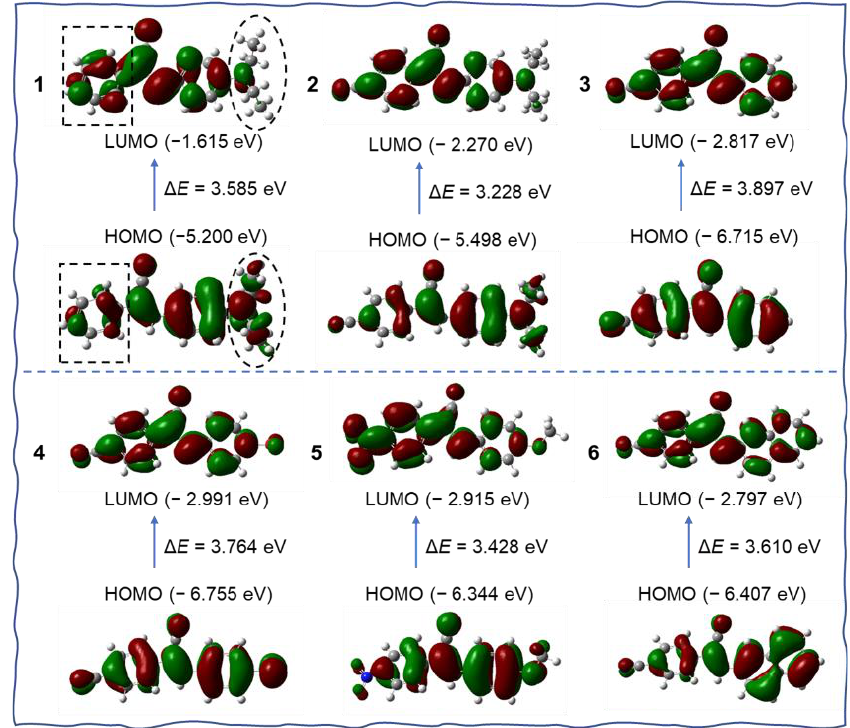
Figure 4. The molecular orbitals of molecules 1 – 6 are calculated by the DFT method. In order to obtain insight into the underlying origins of the remarkable blue-shift and turn-on MC luminescence, the intermolecular interactions in the single-crystal state were studied (Figure 5). Two single crystals suitable for X-ray diffraction were obtained by slow evaporation of the solution of 1 and 2 in mixed CHCl 3 /CH 3 OH solvents. As illustrated in Figure 5A, 1 adopted a twisted molecular conformation in the crystalline state. The dihedral angle between the left phenyl ring and the plane of the double bond is 45.45 ◦ . Such a distorted molecular structure can self-assemble into a loose packing (Figure 5C), which might readily slide upon mechanical grinding to result in MC luminescence. Moreover, some C-H ··· π ( d CH ··· π = 2.896 Å) interactions were obtained in the neighboring molecules (Figure 5B). While the crystal structure of 2 showed a planar molecular conformation and the adjacent molecules arranged in a head-to-tail manner (Figure 5D). Some short contacts, such as C-H ··· π ( d CH ··· π = 3.571 Å), C ≡ N ··· H-C ( d CN ··· HC = 3.373, 3.104,